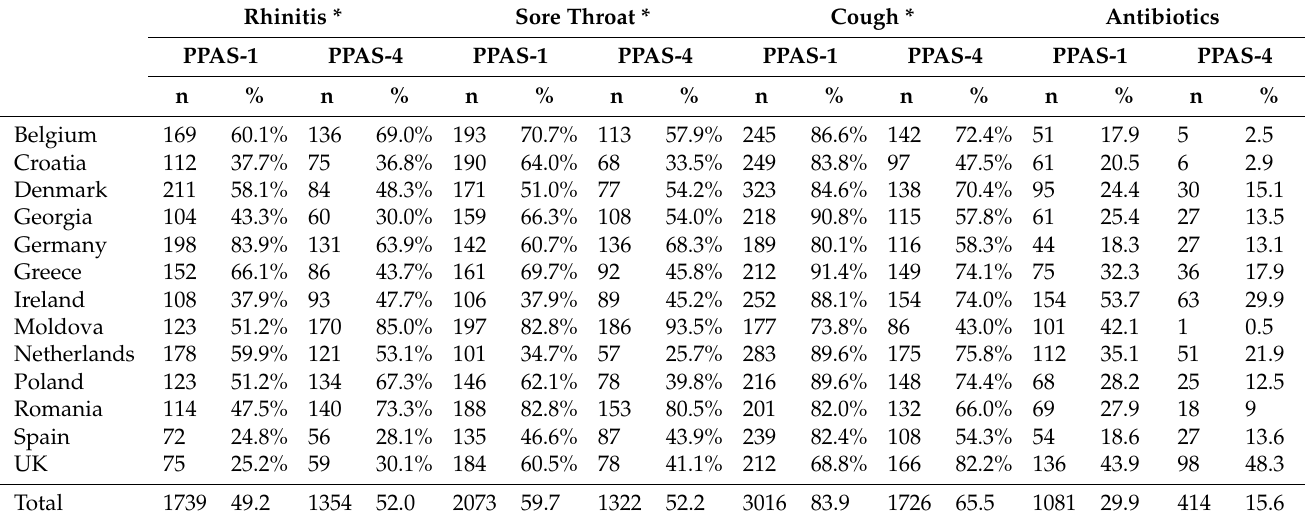
Table 2. Overview of symptoms and antibiotic prescribing recorded in PPAS-1 and PPAS-4 by